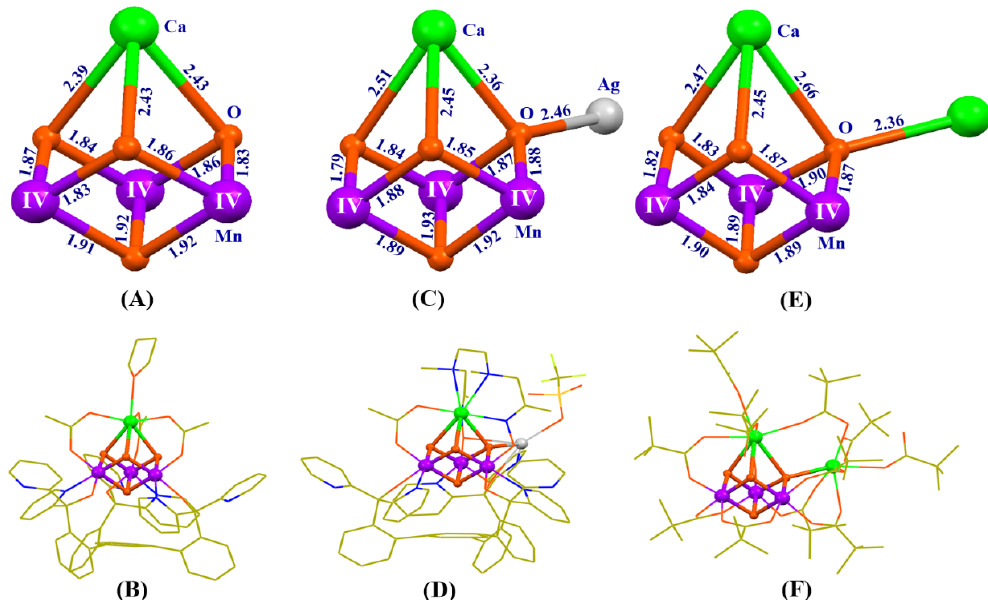
Figure 7. Structures of artificial complexes containing the Mn 3 CaO 4 cubane. ( A ) Core structure of the Mn 3 CaO 4 -complex [107]. ( B ) Whole structure of the Mn 3 CaO 4 -complex [107]. ( C ) Core structure of the Mn3CaAgO4-complex [111]. ( D ) Whole structure of the Mn 3 CaAgO 4 -complex [111]. ( E ) Core structure of the Mn 3 Ca 2 O 4 -complex [112]. ( F ) Whole structure of the Mn 3 Ca 2 O 4 -complex [112]. Distances are given in Å units. Mn, Ca, Ag, O, N, F, S, and C are shown in purple, green, gray, orange, blue, green yellow, bright yellow, and yellow, respectively. For clarity, all hydrogen atoms are not shown.